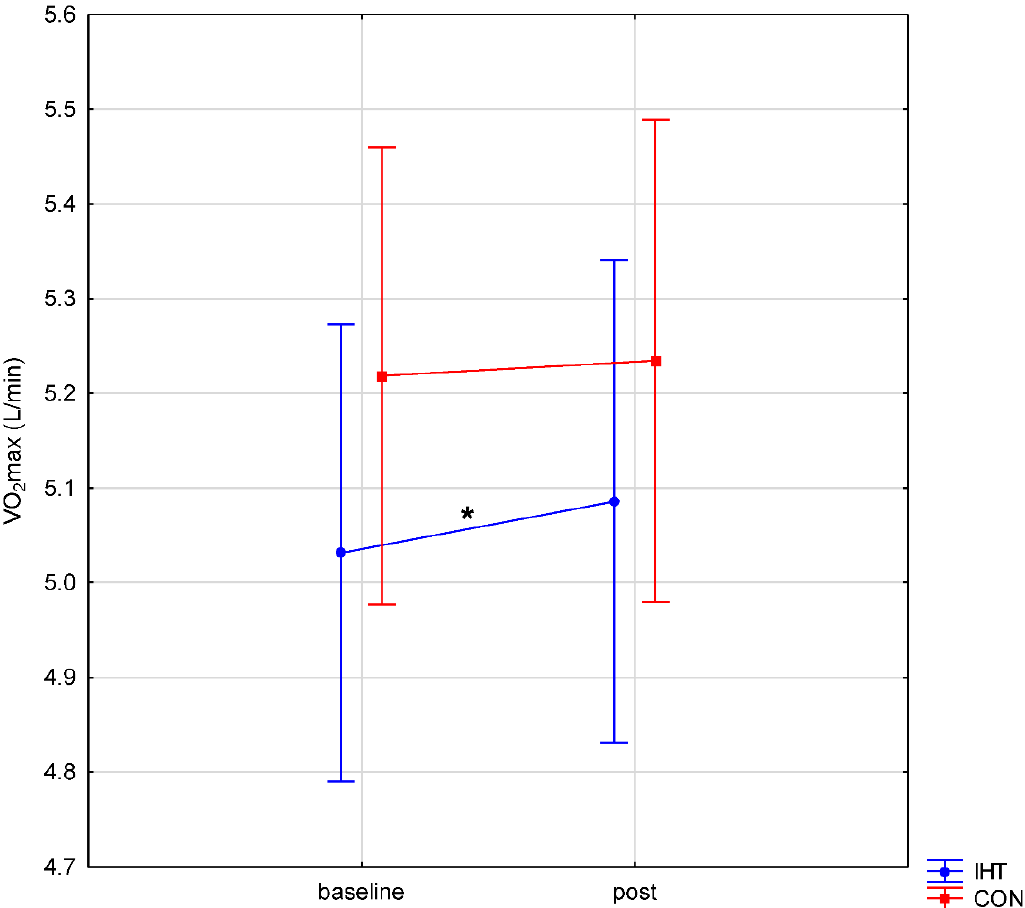
Figure 1. Maximal oxygen uptake (VO 2 max) during intermittent hypoxic training (IHT) and normoxia (CON, control) training (*: p < 0.05).